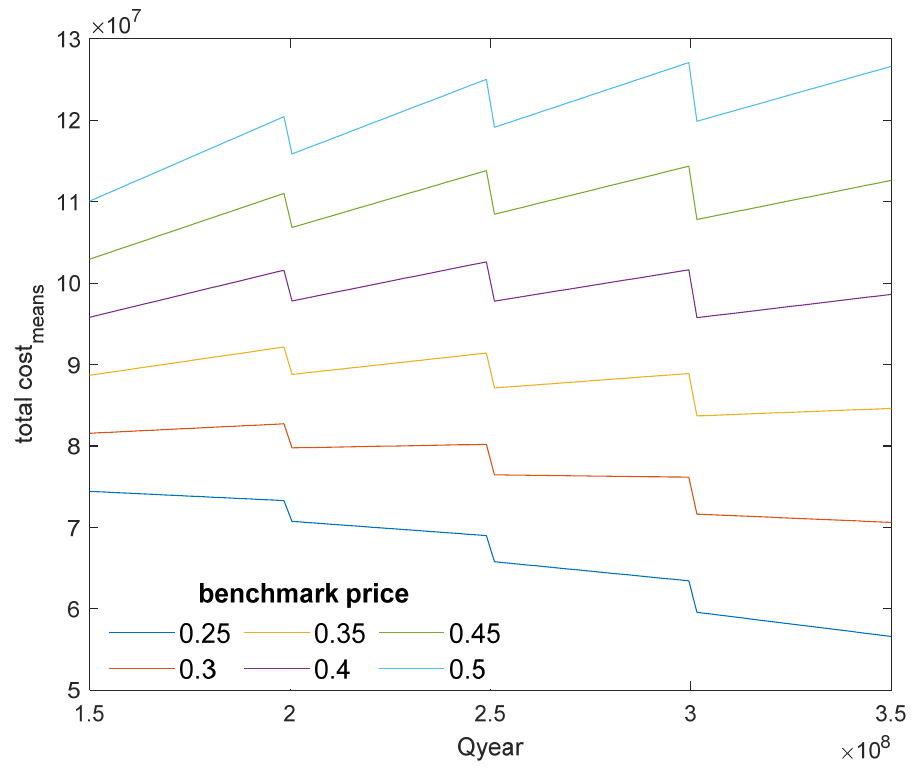
Figure 22. Trend of the total electricity cost under different medium- to-long-term benchmark electricity prices.